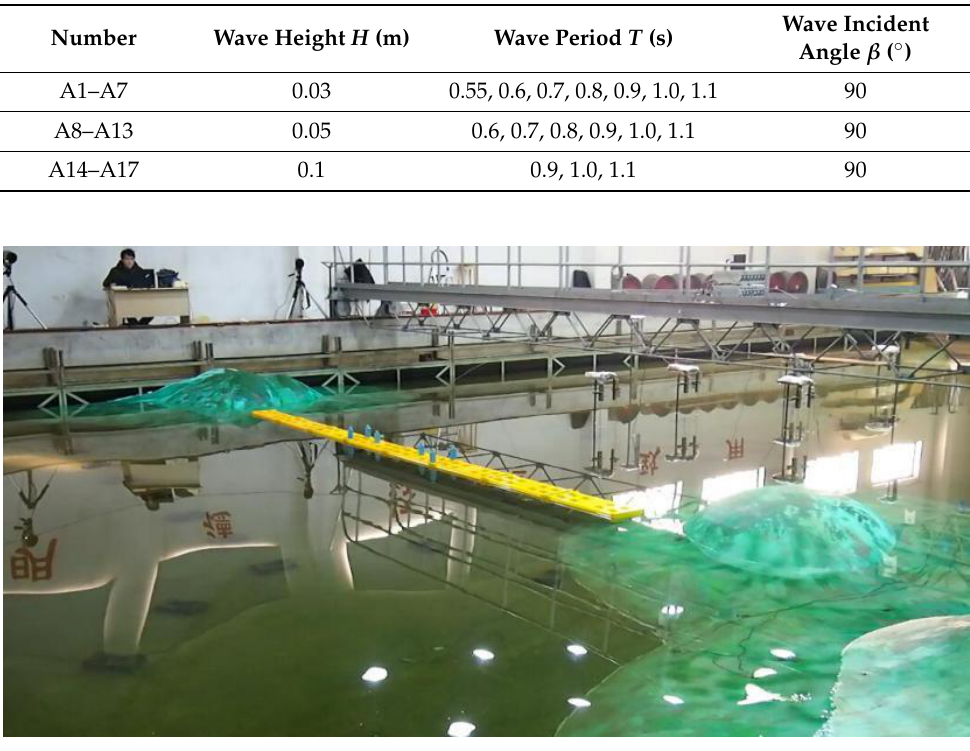
Figure 21. Overall layout of the experiment.